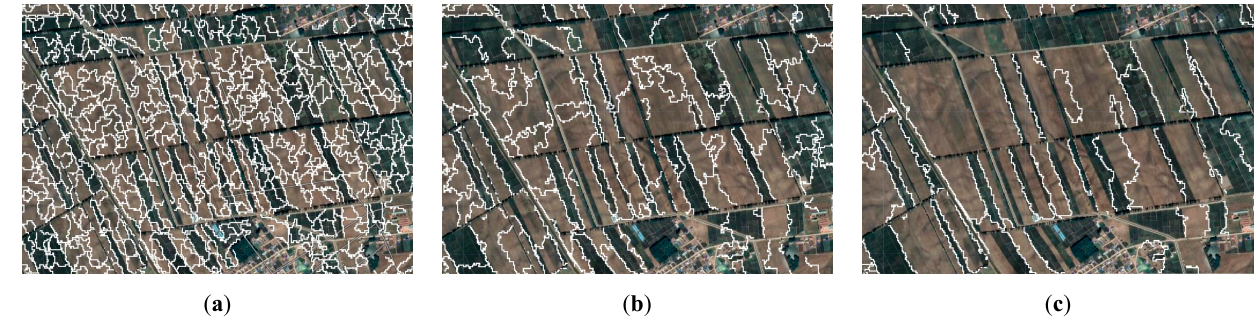
Figure 9. Segmentation results under different “sizes”. “Size” is the superpixel seed location spacing, in pixels. ( a ) Size = 10; ( b ) Size = 20; ( c ) Size = 30.